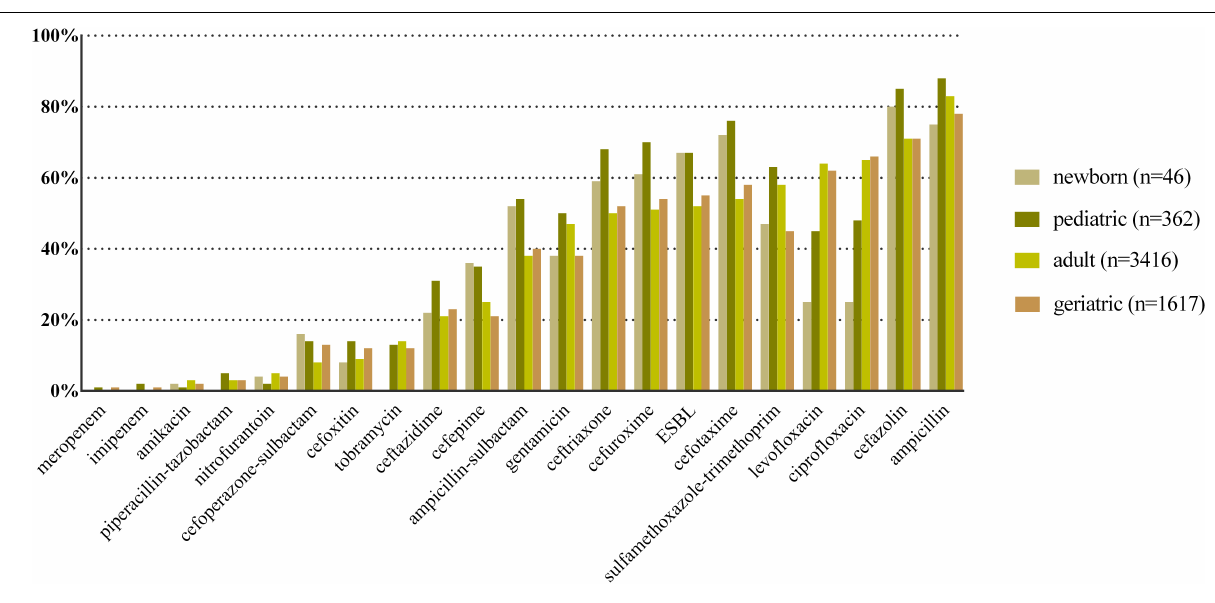
inpatient, ICU, or emergency) and gender (male or female).